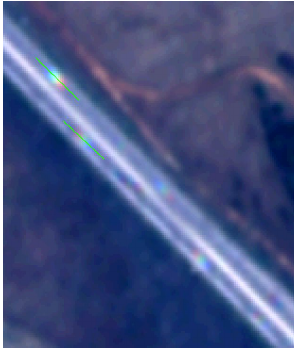
Figure 13: Skybox image showing the displacement of cars in the red, green and blue band, section 620 × 750 m, N568 near Fos-sur-Mer (Camargue, France) Figure 14: Profiles of two cars, left: top profile, right: lower pro- file from fig. 13, bands blue, green, red, NIR (as purple), digitial numbers (DN) vs.